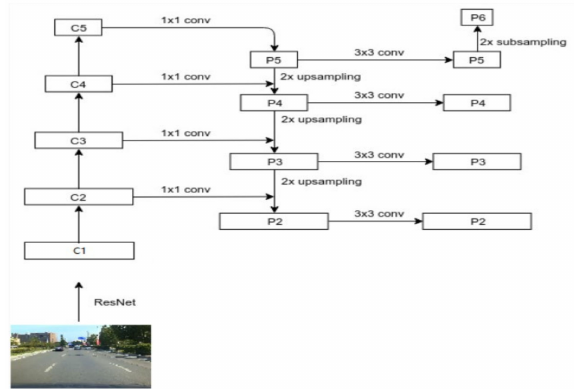
Figure 2. Relationship between Resnet and